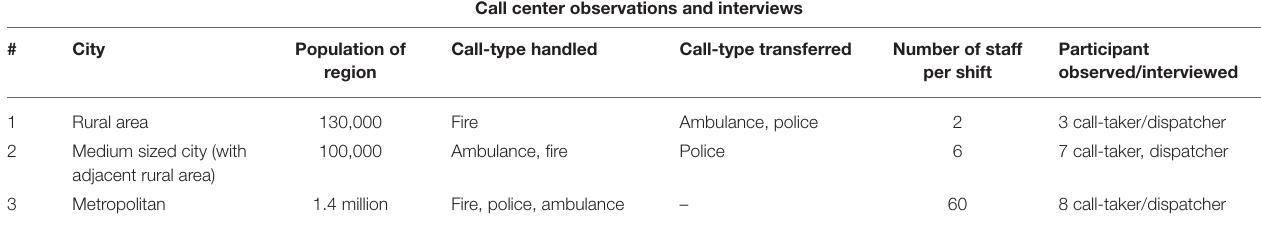
TABLE 1 | Summary of call-center